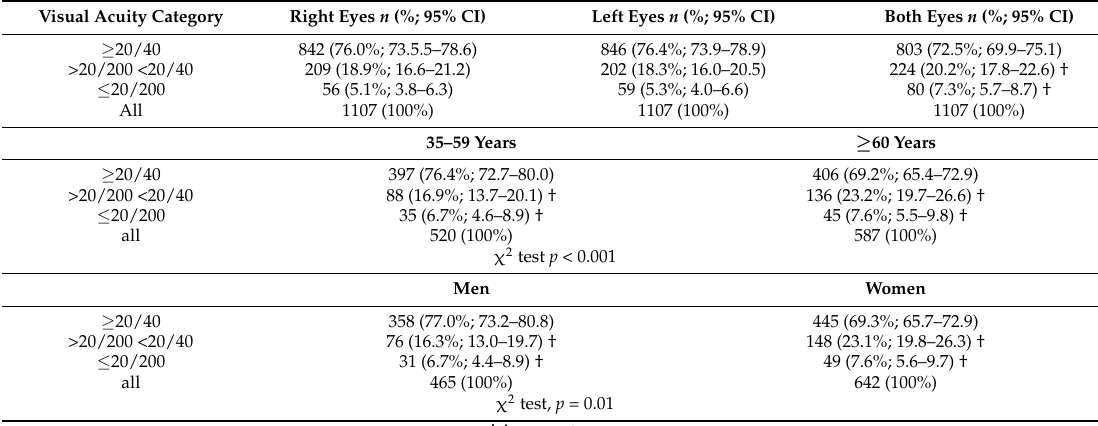
Table 1. Distribution of distance visual acuity among our study subjects.